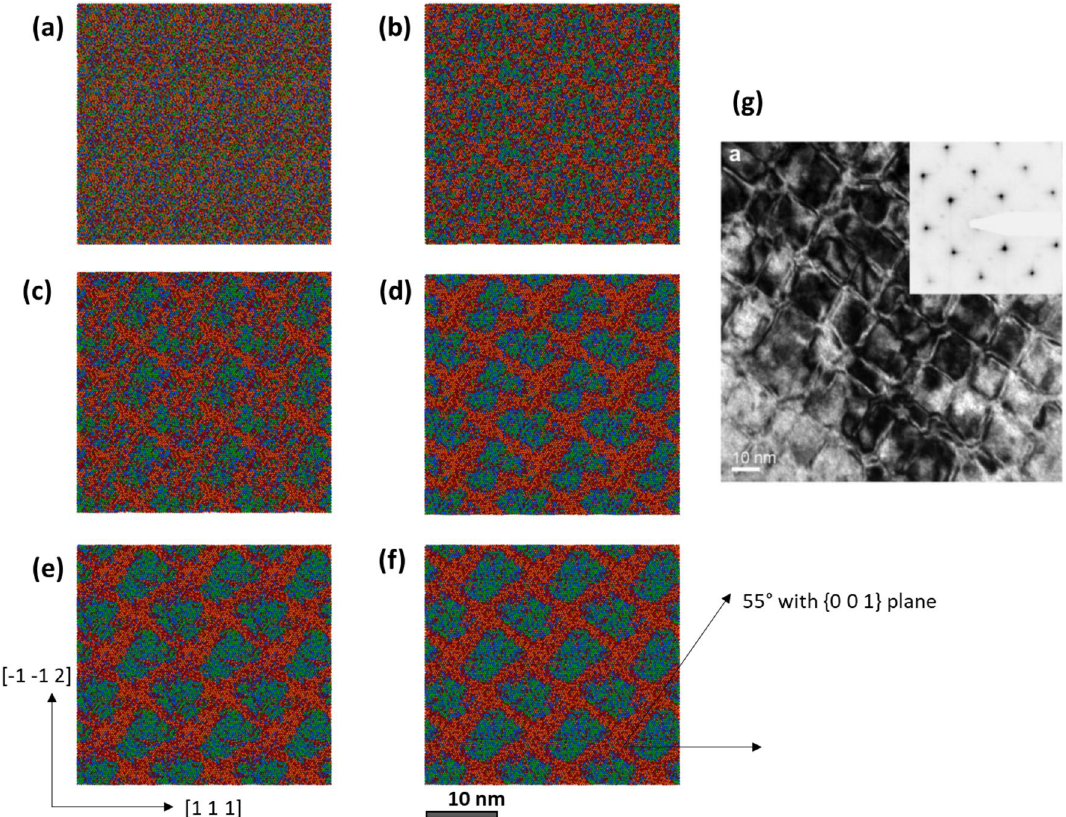
Figure 2. Cross section of MC evolved structure with different colored atom types: ( a ) 0 swap initial structure, ( b ) 5 swaps, ( c ) 10 swaps, ( d ) 20 swaps, ( e ) 30 swaps, ( f ) 40 swaps, respectively. Ta, Nb, Hf and Zr atoms are depicted with green, blue, maroon and orange colors, respectively. ( g ) is adapted from Ref. 12 . ( g ) is the HRTEM image of the 4-day annealed R-HEA taken along [1 0 0] zone axis with selected area diffraction given in the